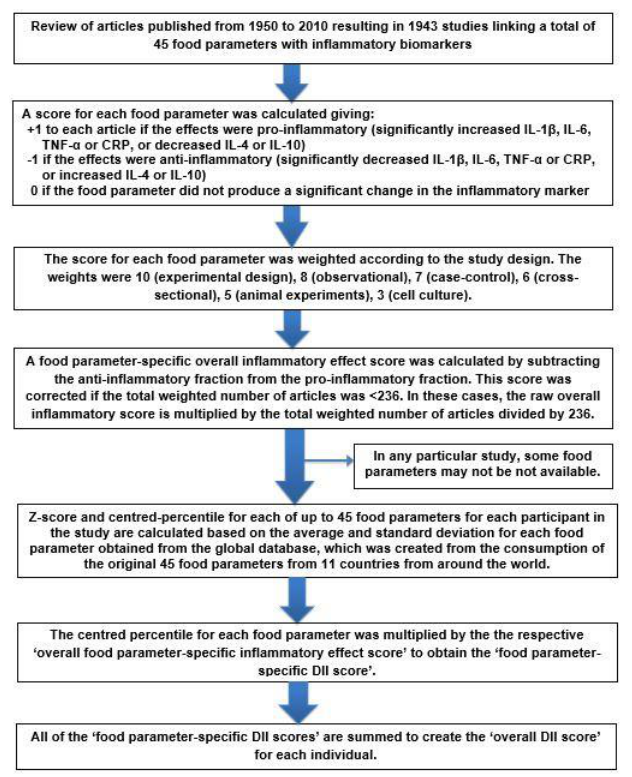
Figure 1. Sequence of steps in creating the Dietary Inflammatory Index (DII ® ).